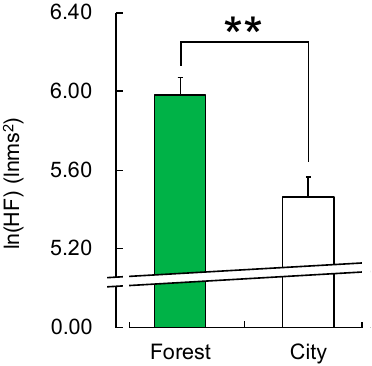
Figure 2. Natural logarithm of the high-frequency power component of heart rate variability, an indicator of parasympathetic nervous system activity, while viewing forest and city areas. Data are shown as means ± standard error ( n = 65). ** p < 0.01, paired t -test (one-sided).